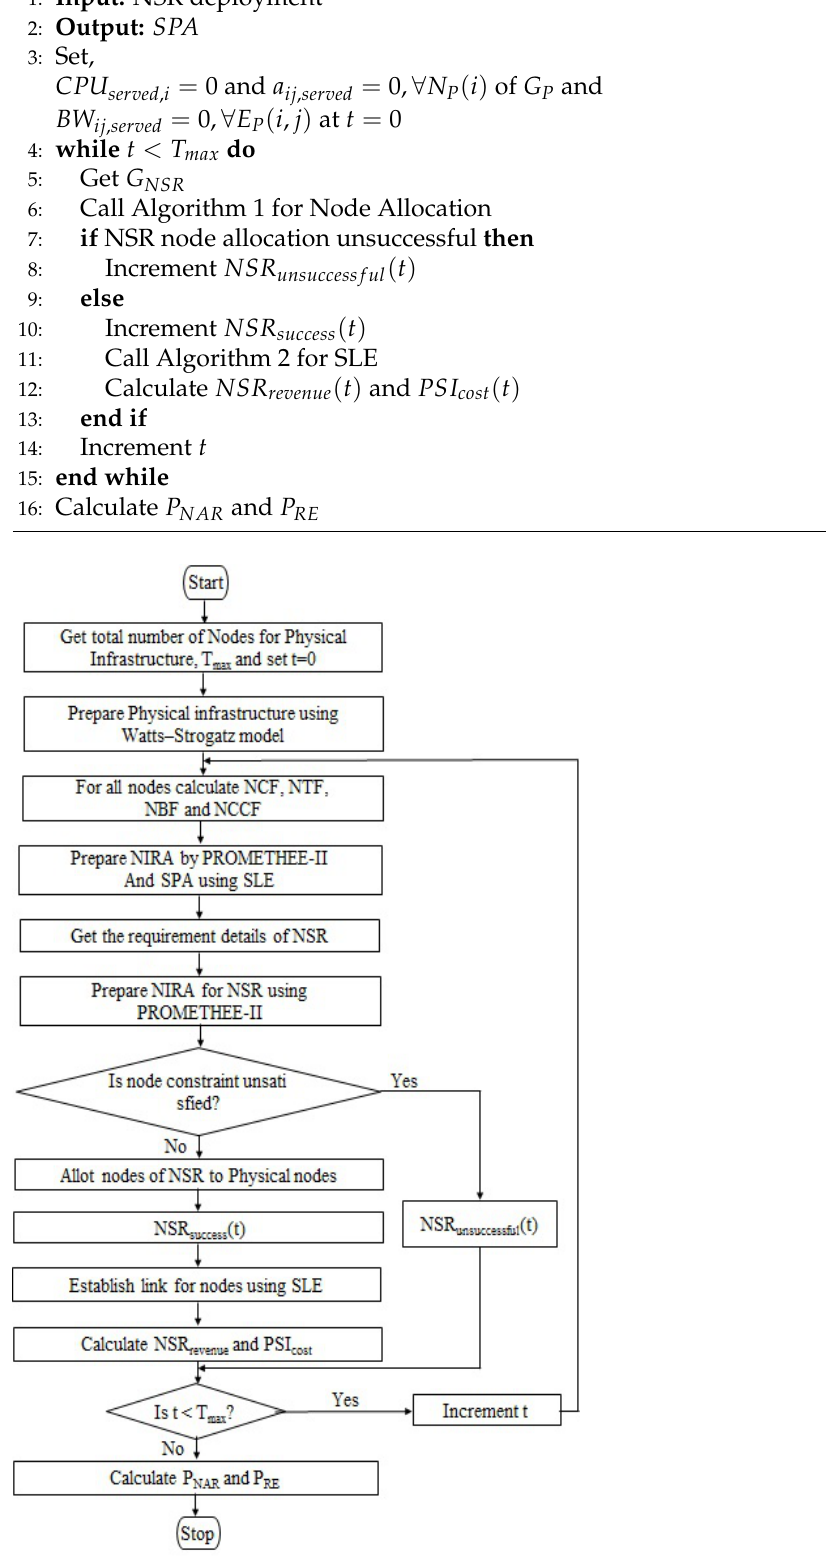
Figure 3. Depicts the sequence of events that occur throughout the whole solution